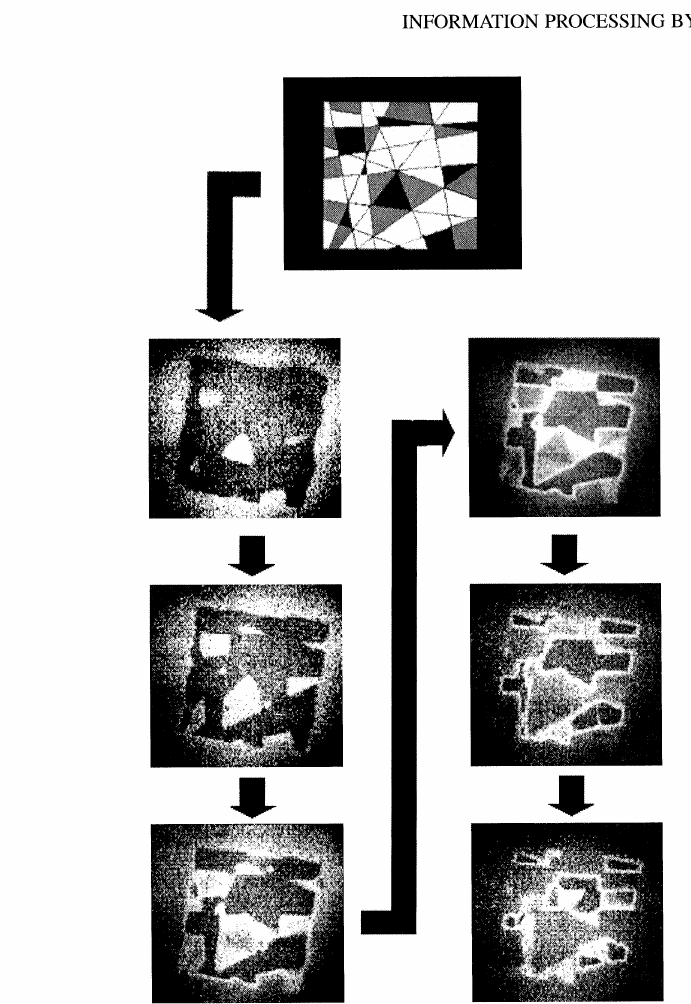
FIGURE 5 Evolution of artificial aerial picture in a light-sensitive Belousov-Zhabotinsky type